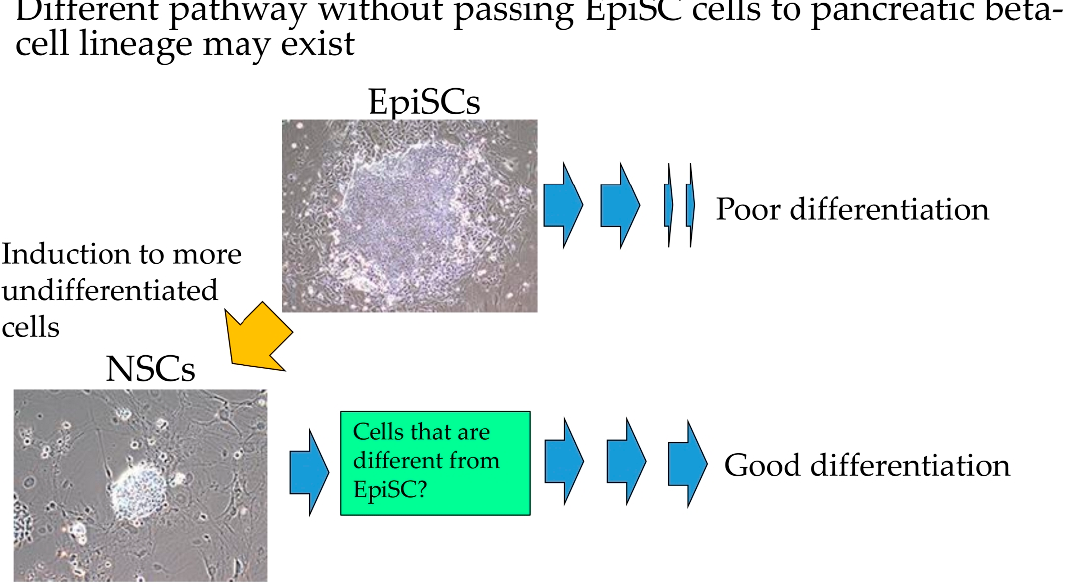
Figure 7. Overall study summary. When epiblast stem cells (EpiSCs) were allowed to differentiate into pancreatic β -cells, the efficiency of generating induced tissue-specific stem cells for pancreatic cells (iTS-P) cells was found to be poor. However, once these cells were converted to the naïve state and then allowed to differentiate, efficient differentiation into iTS-P cells was achieved, with the potential to create β -cells.